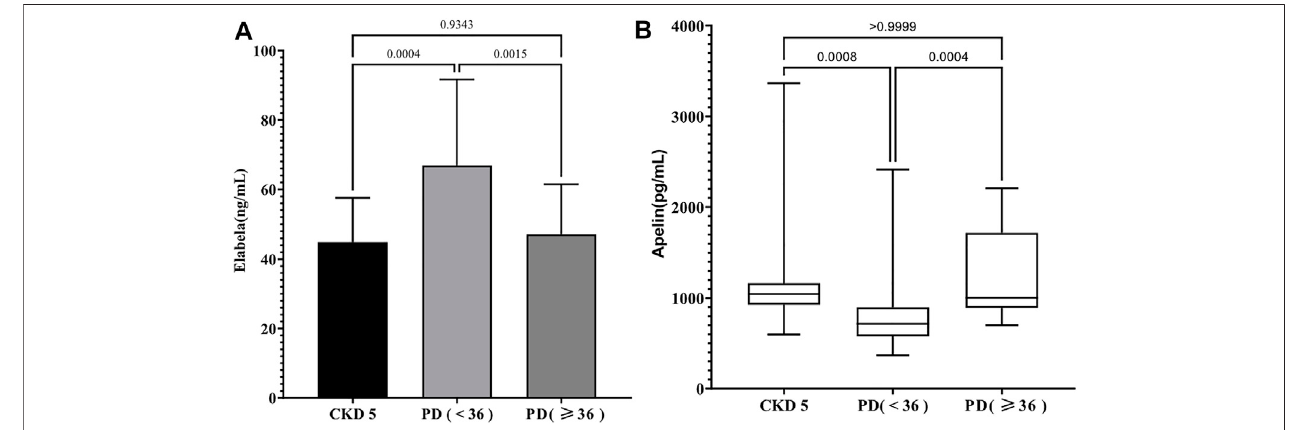
FIGURE 1 | (A) The level of serum ELA in different groups; (B) The level of serum Apelin in different